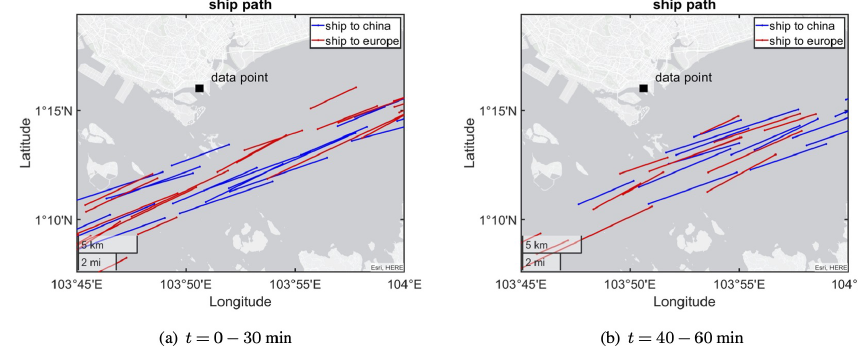
Figure 11. Ship movements during t = 0 − 60min.